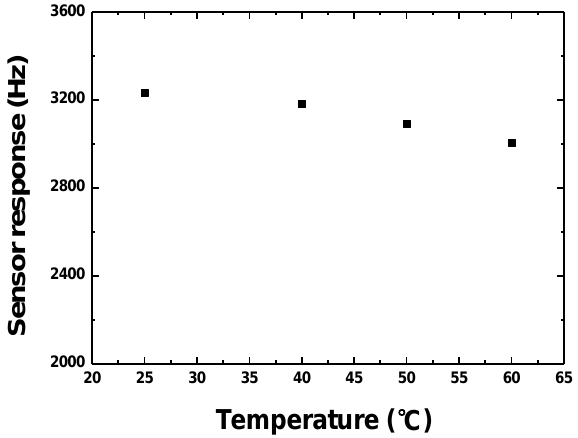
Figure 14. The temperature stability testing of the proposed sensor upon exposure to 5% CH 4 .